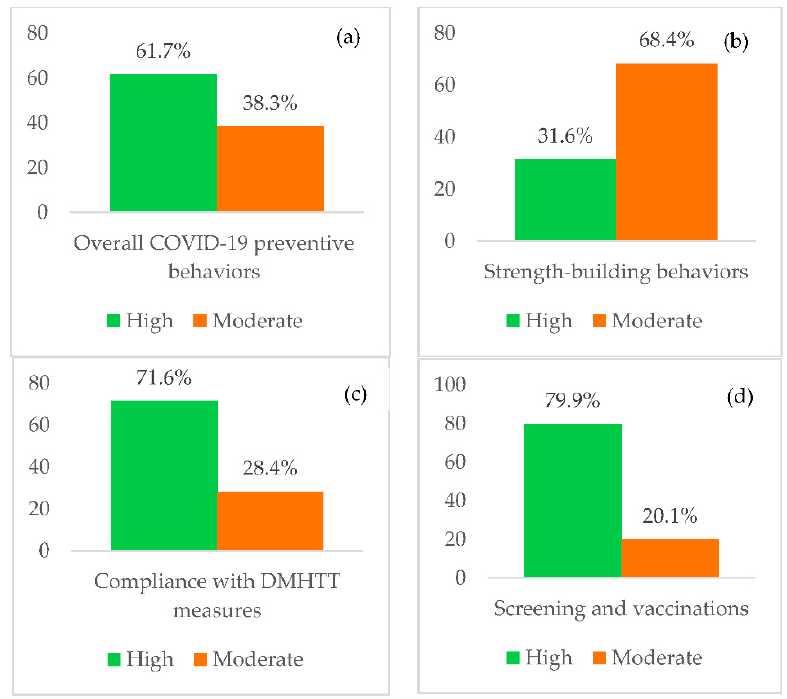
Figure 2. Participant levels of ( a ) overall COVID-19 preventive behaviors; ( b ) strength-building behaviors; ( c ) compliance with DMHTT measures; and ( d ) screening and